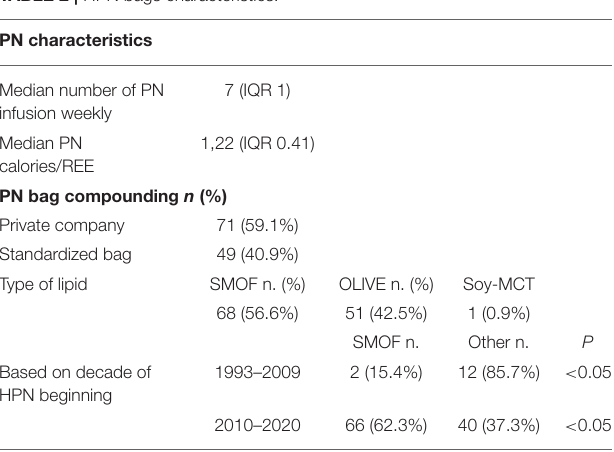
TABLE 2 | HPN bags characteristics. TABLE 3 |